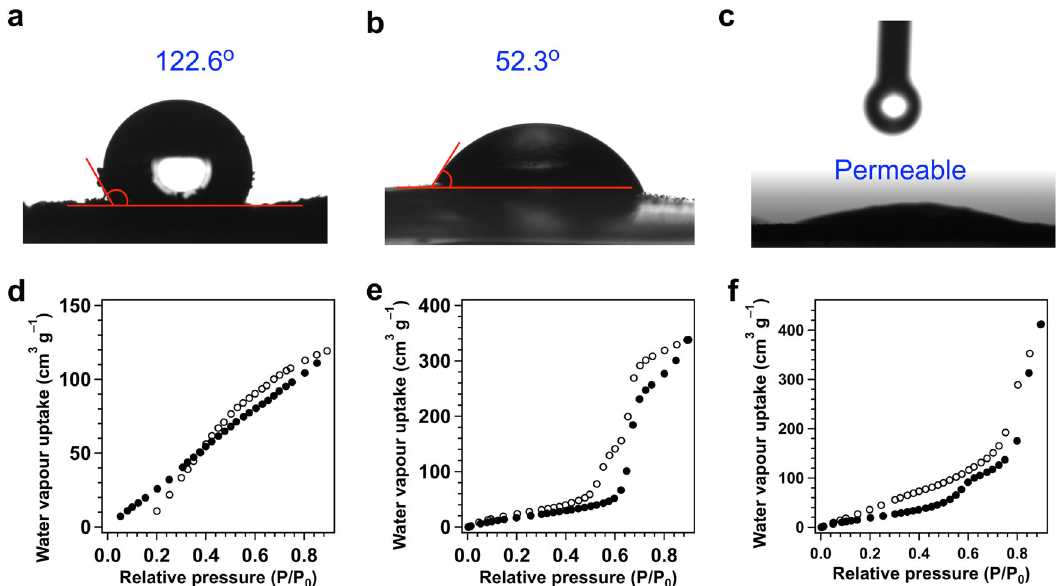
Fig. 4 | Hydrophobicity and water uptake. a – c Images of contact angle measurements of ( a ) ZnP-Pz-COF, ( b ) ZnP-Pz-DHTP-COF and ( c ) ZnP-Pz-PEO-COF. d – f Water vapour sorption isotherms of ( d ) ZnP-Pz-COF, ( e ) ZnP-Pz-DHTP-COF and ( f ) ZnP-Pz-PEO-COF measured at